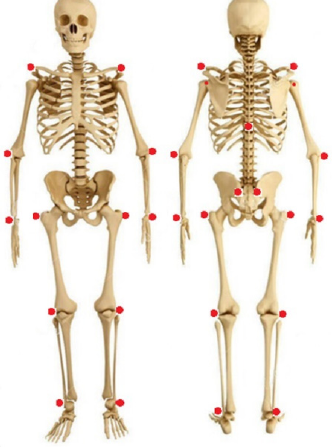
Figure 2. Points where markers were fixed: acromion, lateral elbow epicondyle, external place of wrist (watches wrist placement), spina iliaca posterior superior, trochanter major, lateral epicondyle of the knee, lateral malleolus.